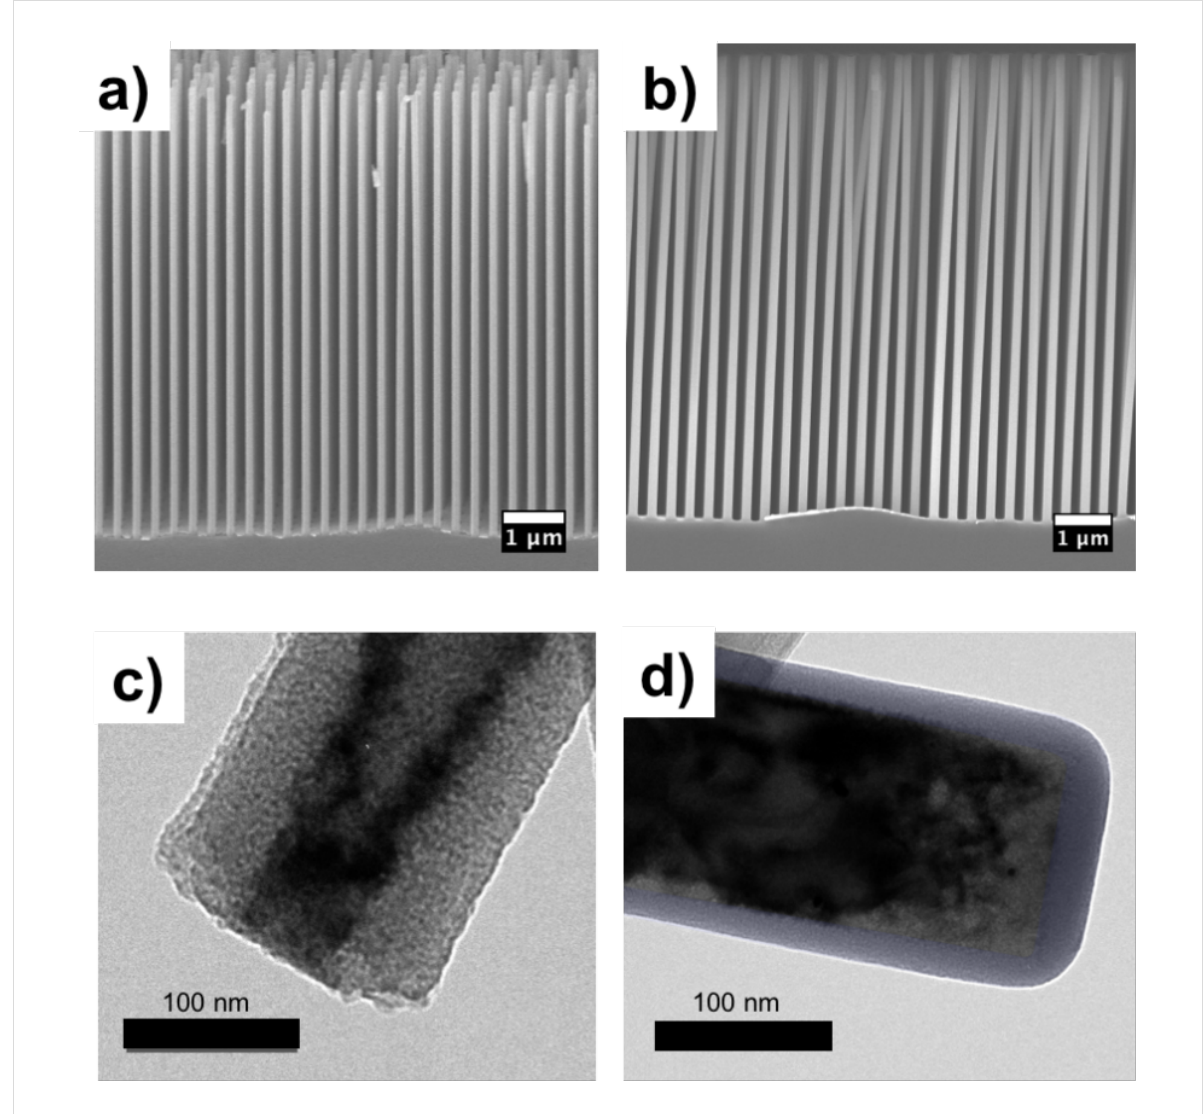
Figure 8: SEM images of a) uncoated ordered Si nanowire array and b) 25 nm iCVD pV4D4 coated ordered Si nanowire array. TEM image of single Si nanowire c) uncoated d) with 25 nm iCVD pV4D4 highlighted in purple.